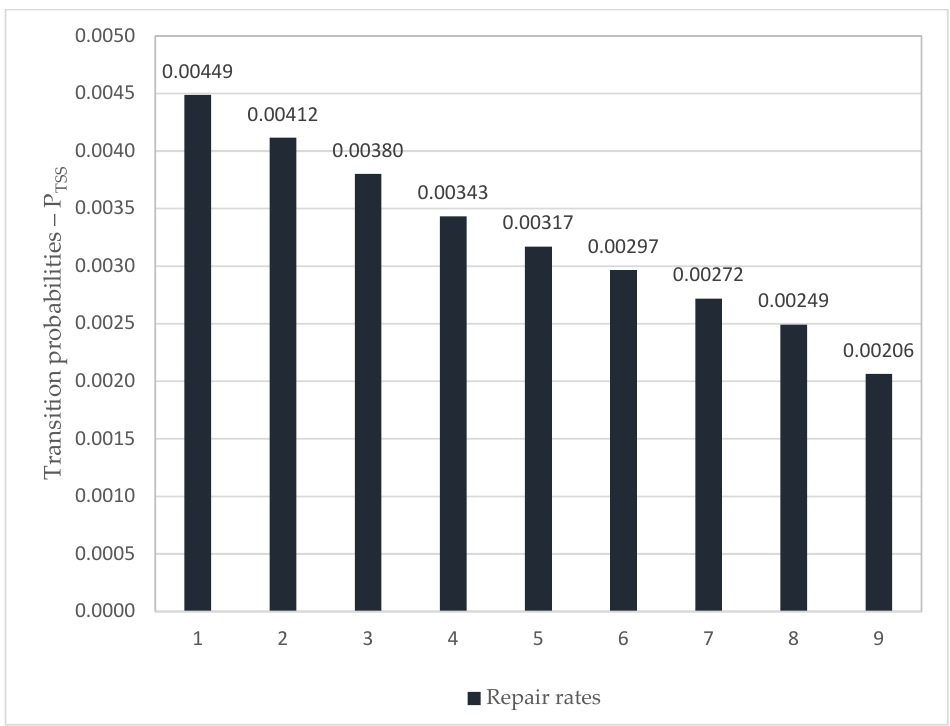
Figure 8. Dependence of the P TSS values on the repair rates µ TSS and µ LSS acc. to Figure 6, for constant failure rates λ CSS = 0.0028379 d − 1 , λ TSS = 0.0007703 d − 1 , and λ LSS = 0.0000220 d − 1 .